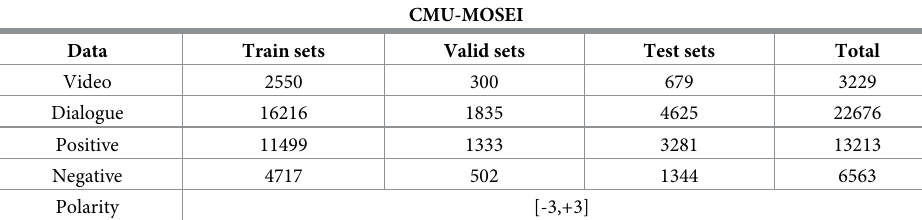
Table 2. CMU-MOSEI dataset